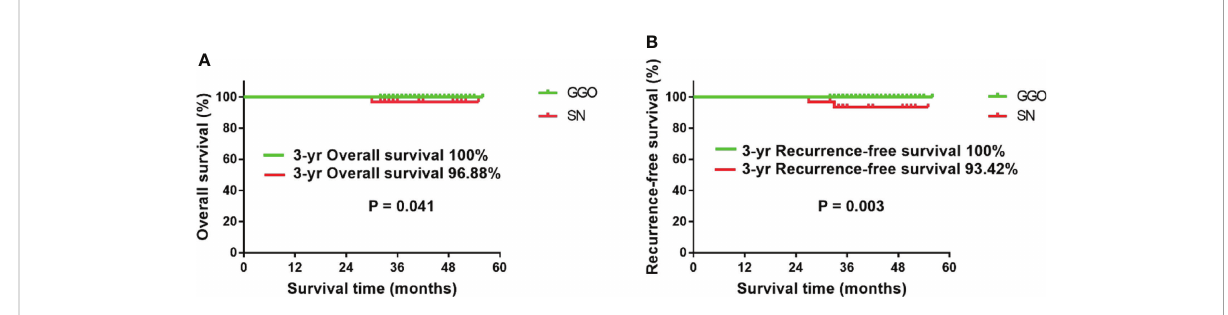
FIGURE 2 Survival analysis of the two groups of patients. (A) The 3-year OS of the GGO group was signi fi cantly better than that of the SN group (P=0.041); (B) the 3-year RFS of the GGO group was signi fi cantly better than that of the SN group